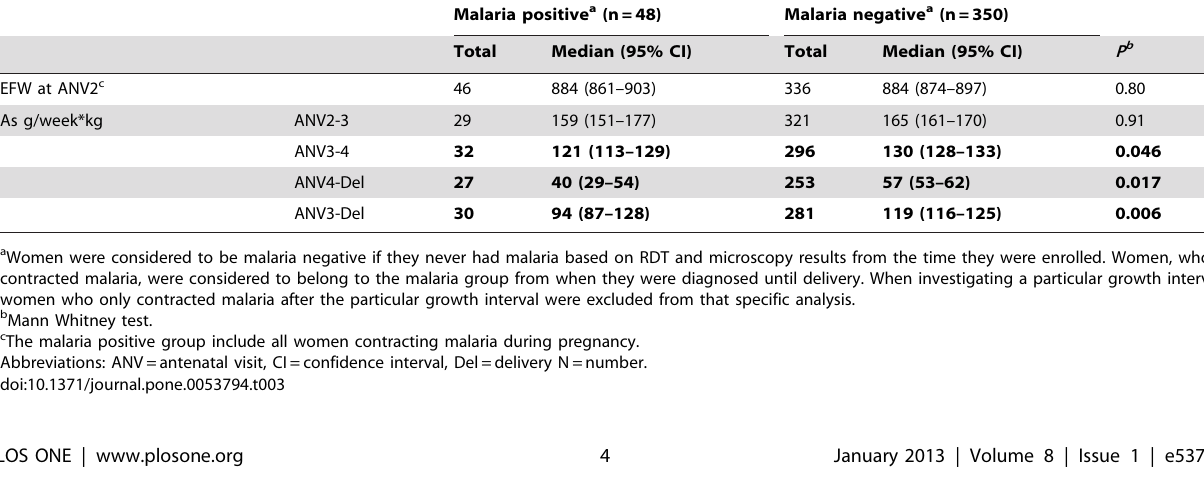
Malaria positive a